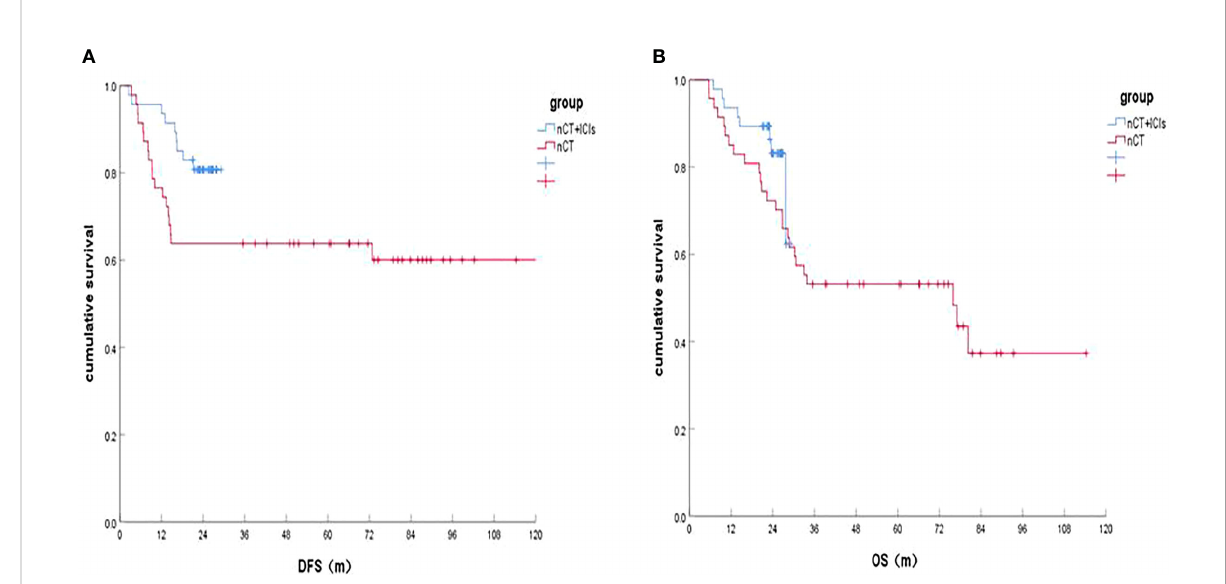
FIGURE 1 Survival of the nCT+ICIs group and nCT group after follow-up. (A) DFS rates between the two groups; (B) OS rate between the two groups.